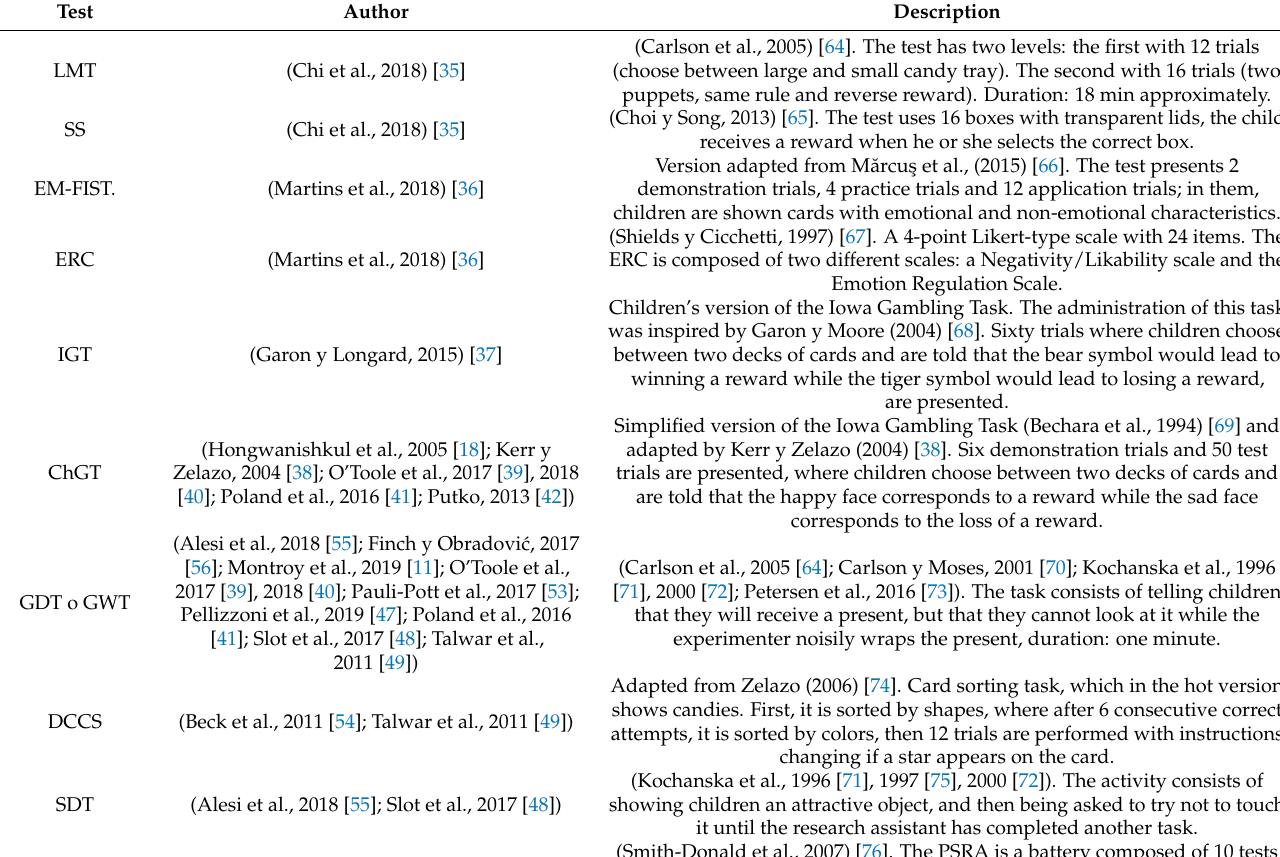
Table 2. Hot EF Test